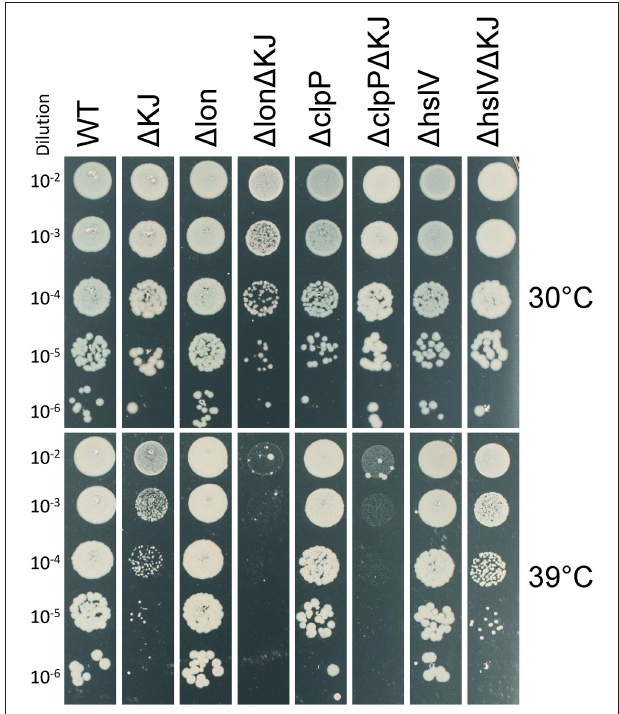
FIGURE 4 | hslV deletion improves growth in the 1 KJ background. Serially 10-fold diluted cultures of wild type (WT), 1 KJ, or 1 KJ combined with the indicated single-protease deletions ( 1 lon , 1 clpP, and 1 hslV ) were spotted on agar plates and grown overnight at 30 ◦ C (top) or 39 ◦ C (bottom)